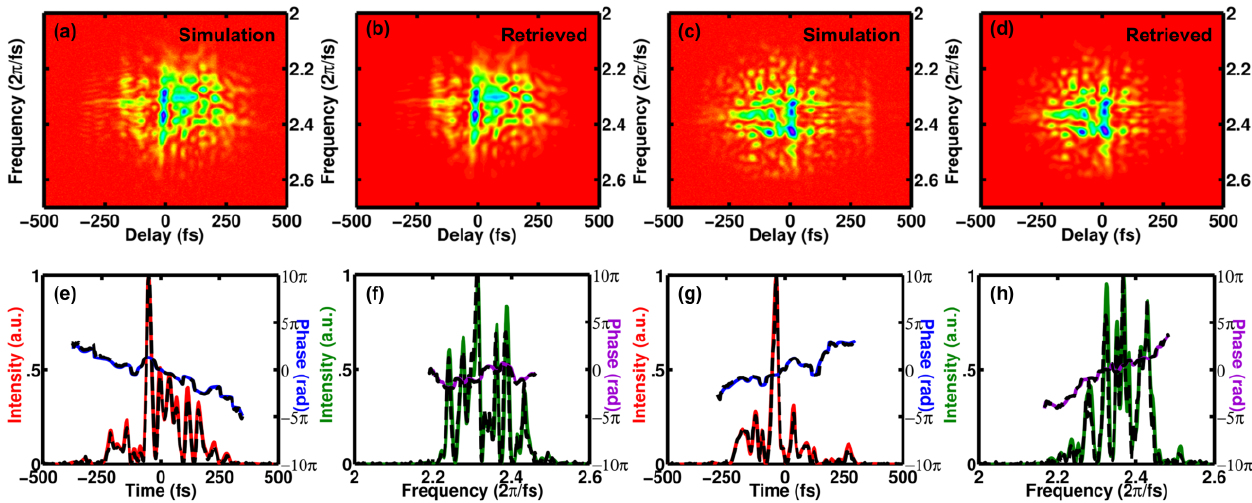
Figure 10. Simulations of DB PG FROG for two complex pulses. The two “measured” traces ( a ) and ( c ) are shown in the traces labeled “Simulation”, and their retrieved traces ( b ) and ( d ) are shown to their immediate right. The retrieved intensities and phases are shown in ( e ) to ( h ) by the solid-color lines. The actual intensity and phase of the simulated pulses are shown as dashed black lines. Both of these simulated complex pulses have time-bandwidth products of about seven, and 1% additive Poisson noise was added to the simulated traces to simulate noisy measurements